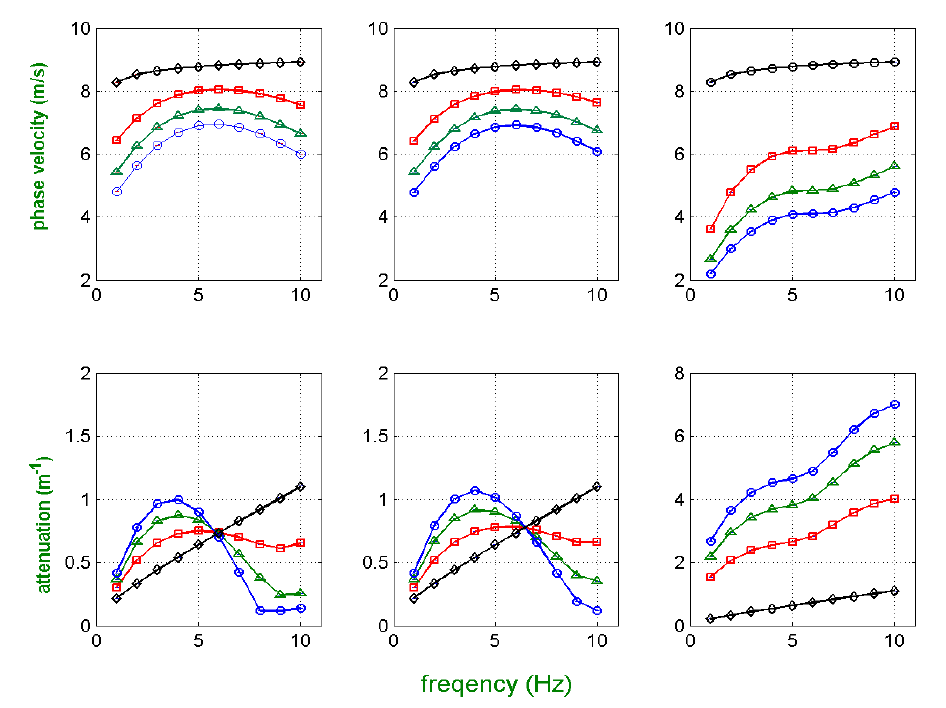
Fig. 8 Frequency patterns of phase velocity (top panels) and attenuation (bottom panels) for various time lags ( dt ) between radius and flow velocity at position x 2 . Each panels contain the values obtained on three different time